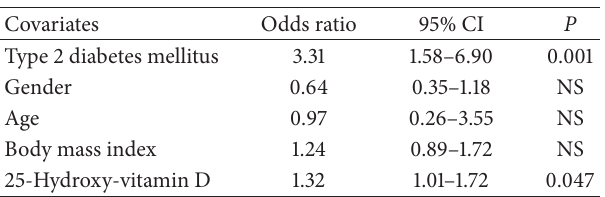
Table 2: Multivariable logistic regression using thyroid autoimmu- nity as the dependent variable.